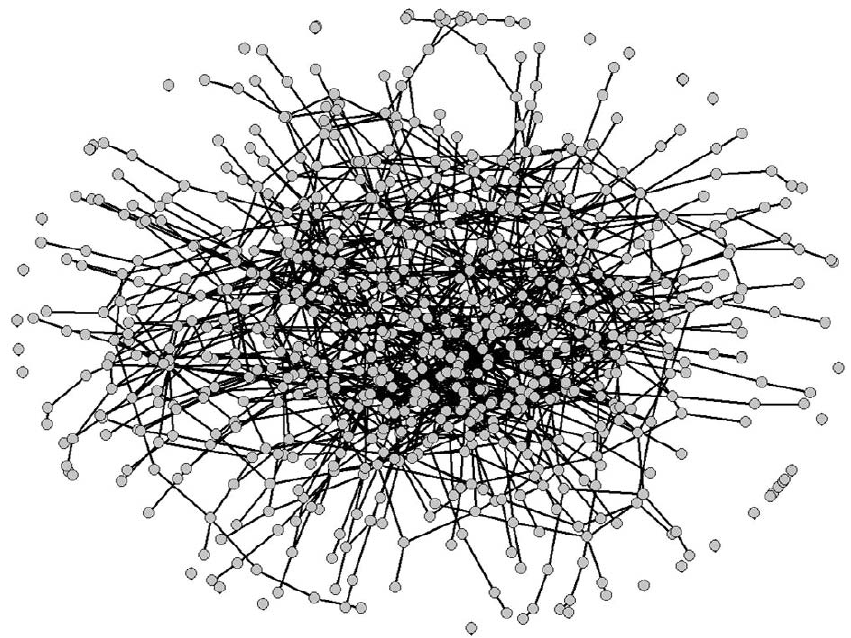
Figure 5. Evolved Metabolic Network The functional network of a cell with phylogenetic depth 5,000, with 969 nodes and 1,698 edges.